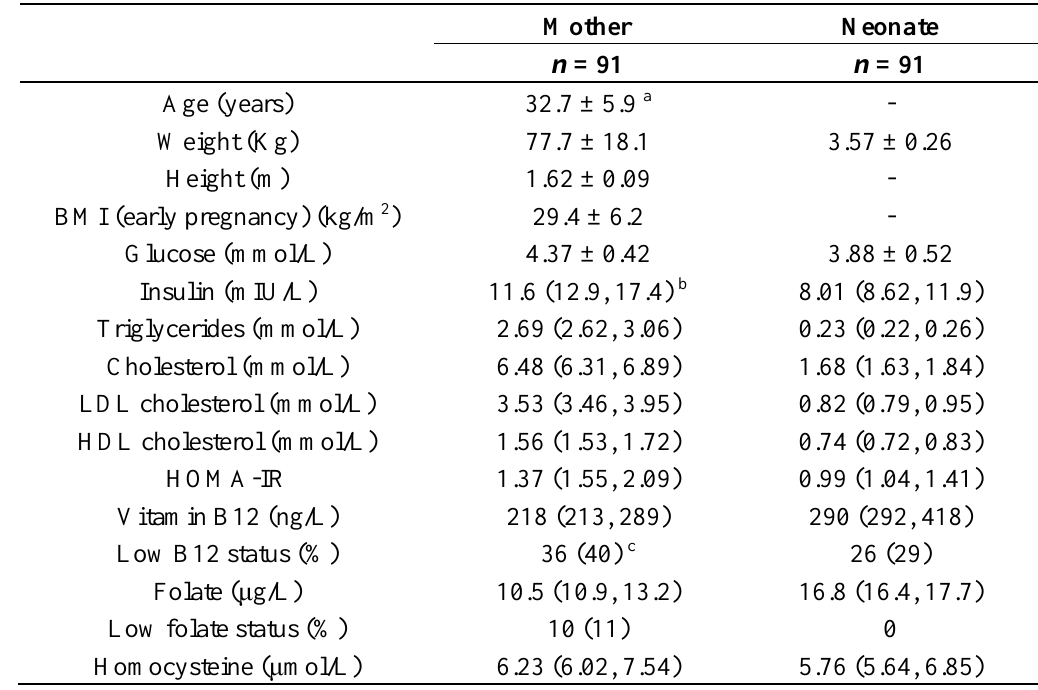
Table 1. Clinical characteristics of mothers and neonate.